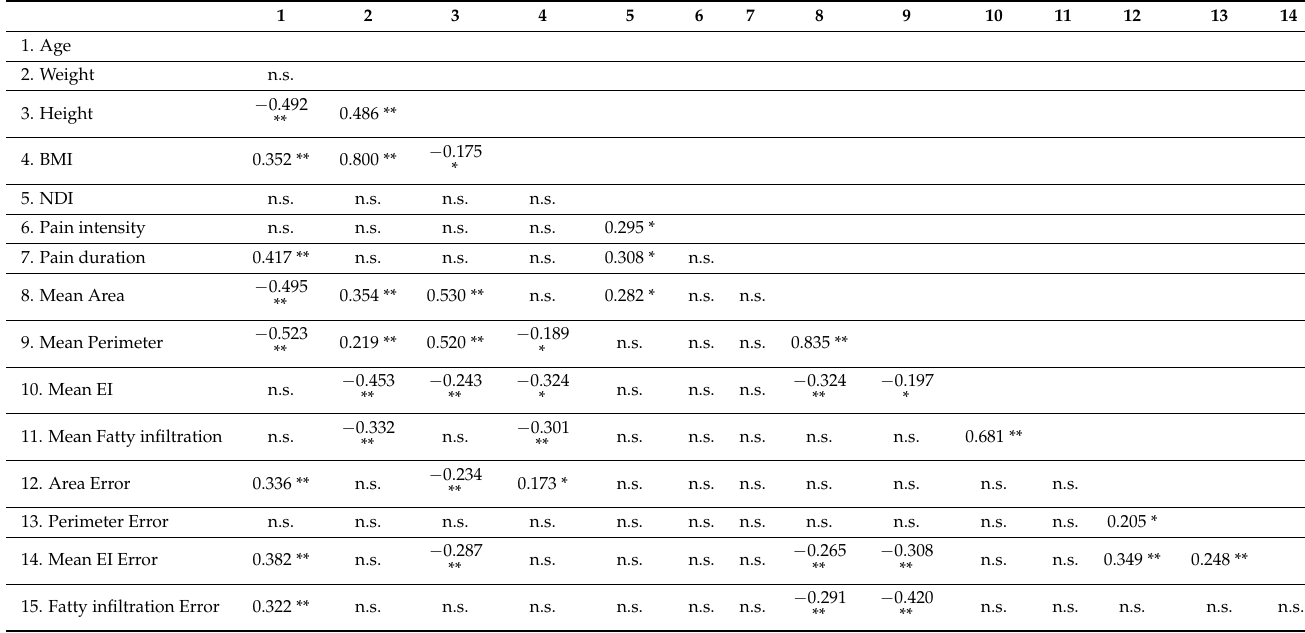
Table 3. Pearson-Product Correlation